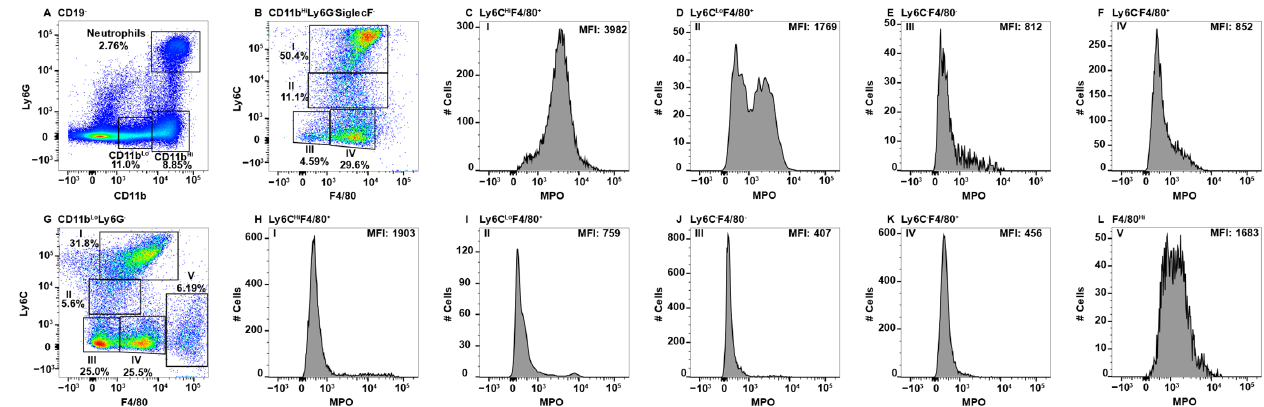
Figure 3. Splenic monocyte/macrophage subsets differentially express MPO. Splenocytes were stained with antibodies specific for CD19, CD11b, Ly6C, Ly6G, F4/80, MPO, and SiglecF and using flow cytometry, CD19 − cells were analyzed for Ly6G and CD11b to identify double positive neutro- phils and Ly6G − CD11b Hi and Ly6G − CD11b Lo cells ( A ). CD11b Hi Ly6G − SiglecF − cells were analyzed for F4/80 and Ly6C expression and four Subpop (I–IV) were identified ( B ). MPO expression in Sub- pop I F4/80 + Ly6C Hi ( C ), II Ly6C Lo F4/80 + ( D ), III Ly6C − F4/80 − ( E ), I and IV Ly6C − F4/80 + ( F ) is shown. CD11b Lo Ly6G − SiglecF − cells were analyzed for F4/80 and Ly6C expression and five Subpop (I–V) were identified ( G ). MPO expression in Subpop I F4/80 + Ly6C Hi ( H ), II Ly6C Lo F4/80 + ( I ), III Ly6C − F4/80 − ( J ), IV Ly6C − F4/80 + ( K ), and V Ly6C − F4/80 Hi ( L ) is shown. The percent positive cells in dot plot gates and the MFI of histograms is provided. Data shown are representative of three mice.